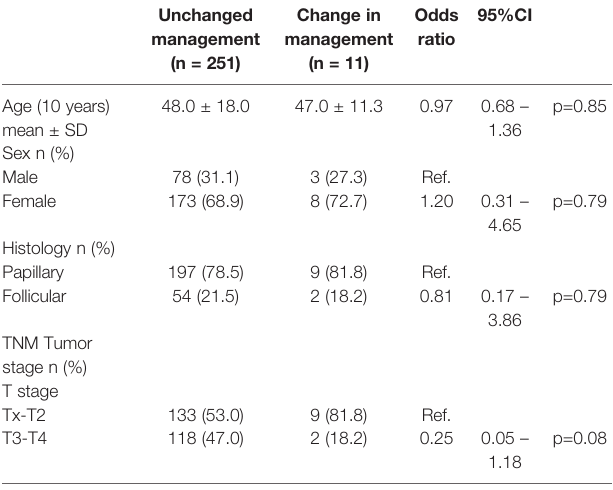
TABLE 2 | Patient and treatment characteristics associated with a change in clinical